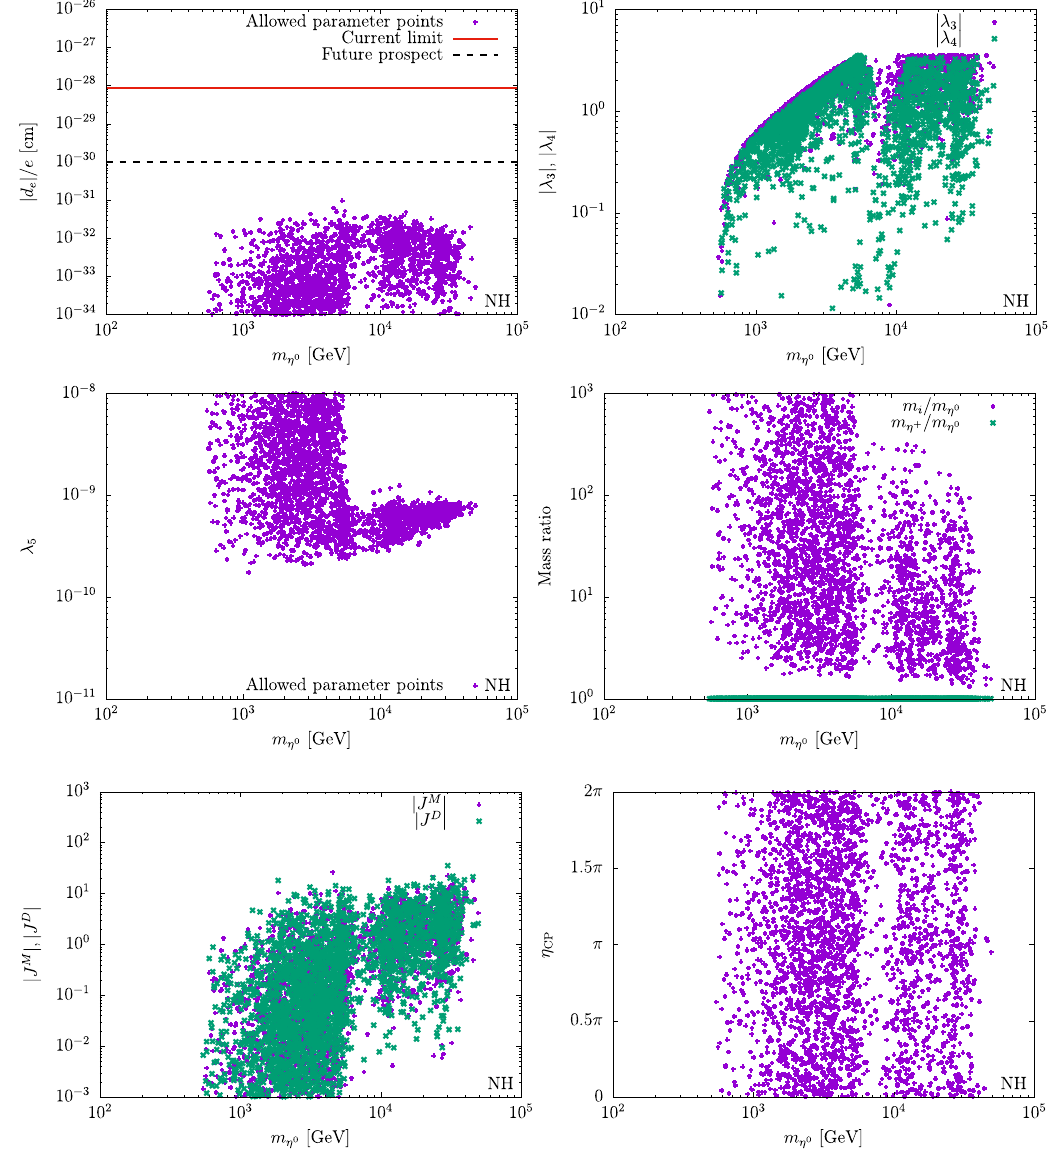
Figure 6 . Numerical results for scalar dark matter in the case of normal ordering of the light neutrino mass spectrum. Each point complies with all the constraints discussed in section